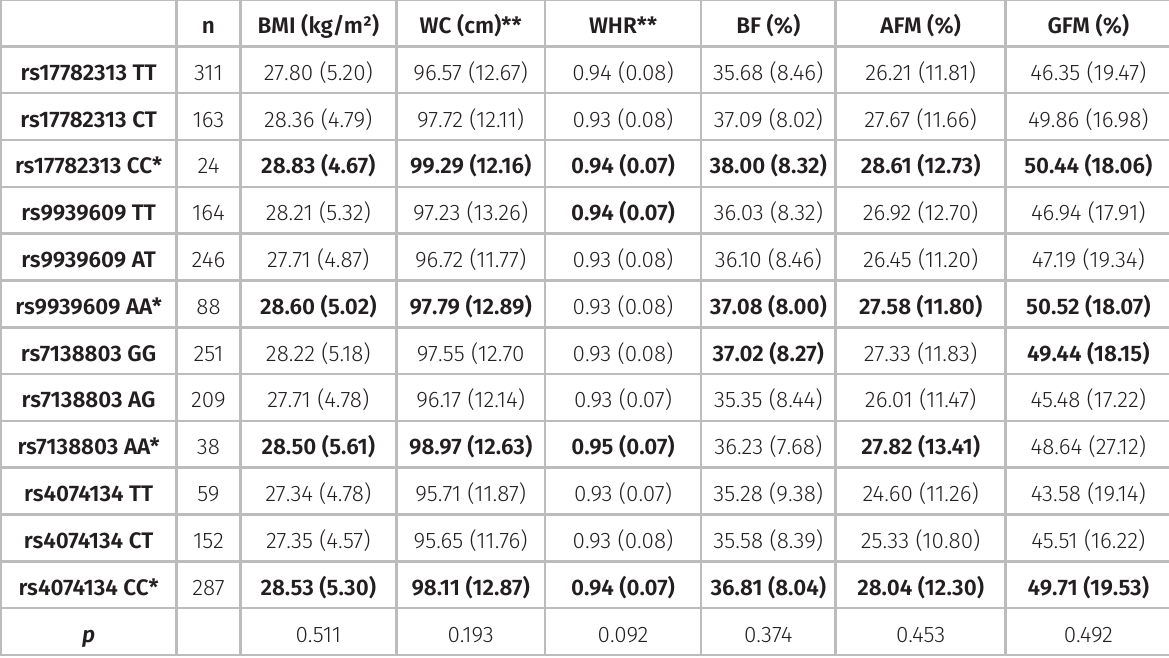
Table V. Means, standard deviations and p -values of the obesity-related parameters for each genotype of the four genetic loci, as well as the frequencies of each genotype in the population